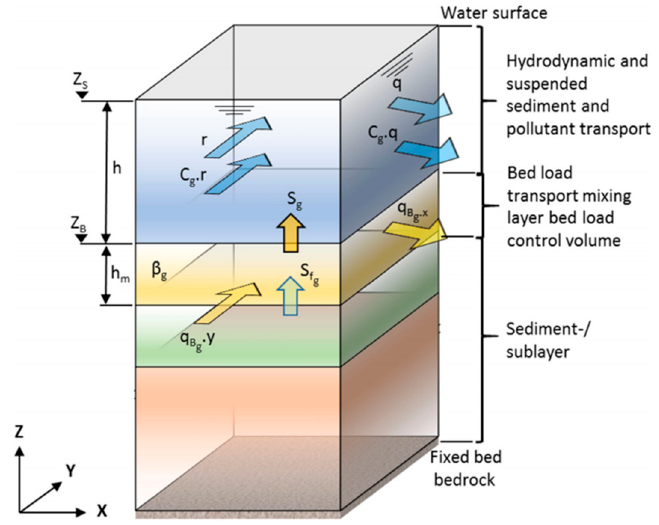
Figure 5. Vertical discretization of a computational cell in the BASEMENT system.